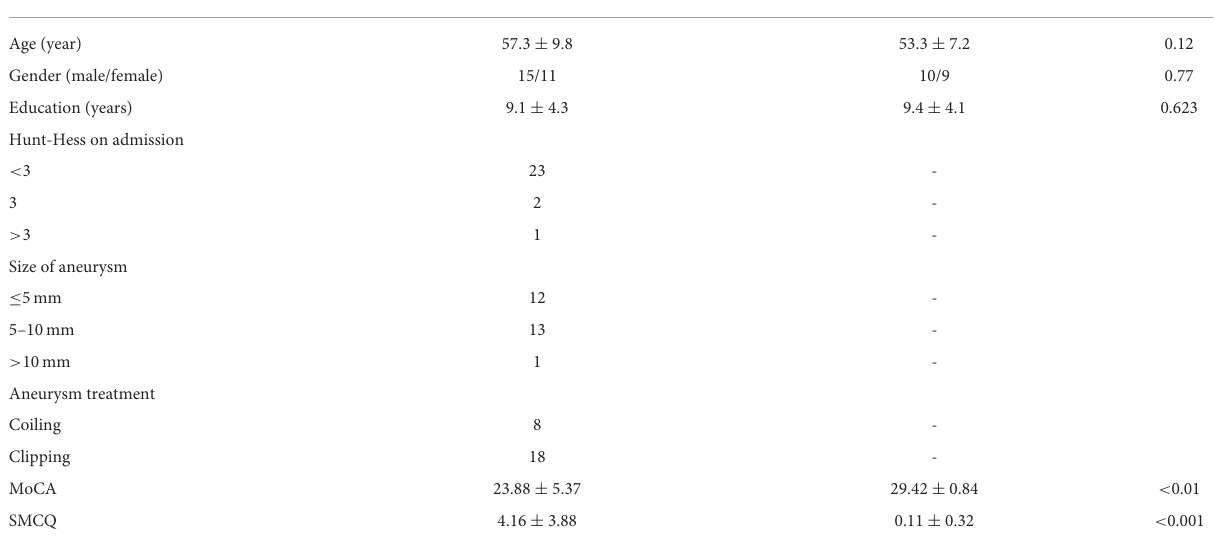
TABLE 1 Clinical features of all the participants. Patients with ruptured ACoA